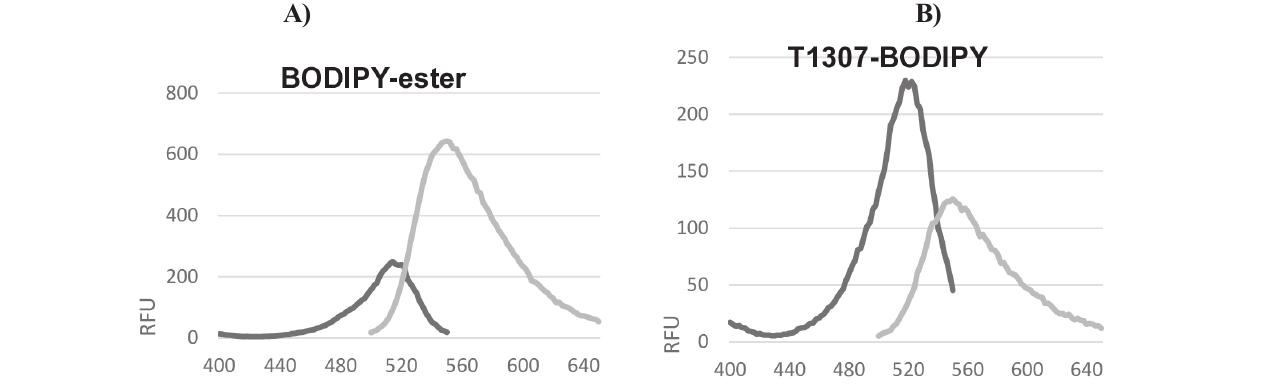
FIGURE 4 – UV/Vis absorption (black lines) and fluorescence excitation (gray lines) spectra. A) BODIPY-ester (λ